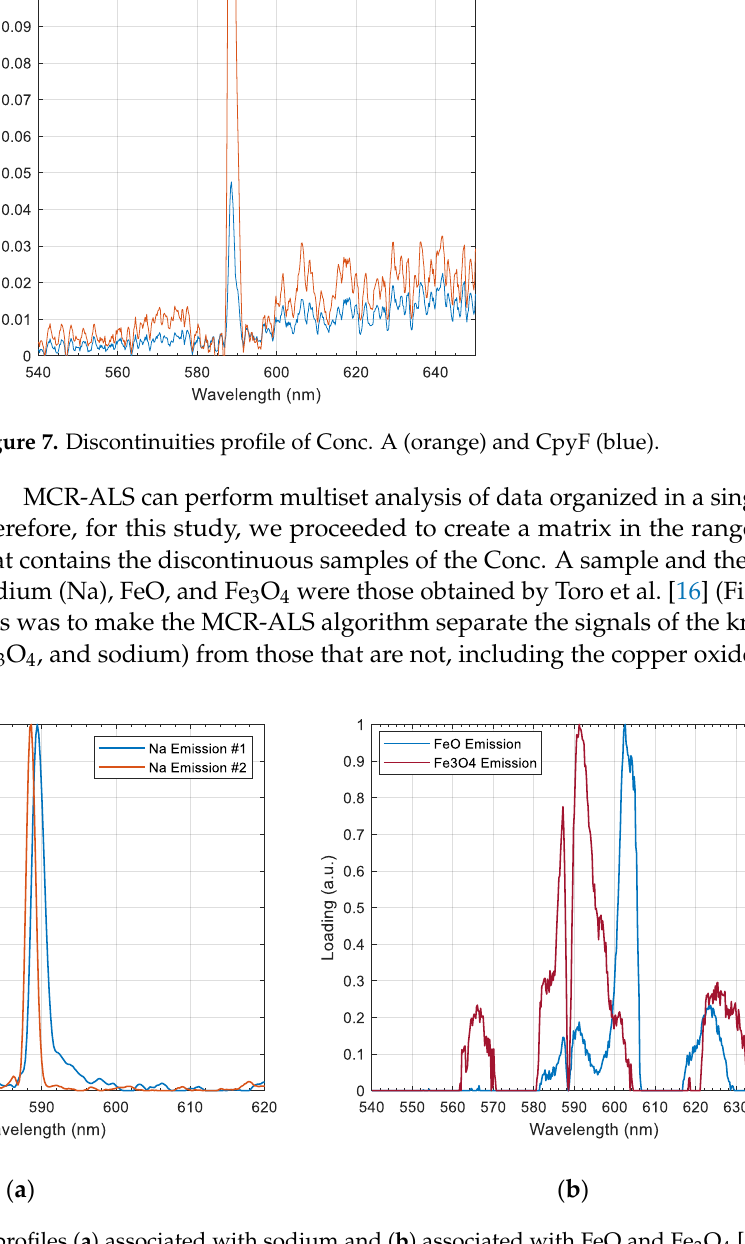
Figure 8. Spectral profiles ( a ) associated with sodium and ( b ) associated with FeO and Fe 3 O 4 [16]. The MCR-ALS method was applied to the new matrix, as detailed in Figure 9, with 10 components and a “non-negativity” restriction on spectral profiles and concentrations. With these settings on the MCR-ALS GUI, 92.5244% of the data variance and an error of fit (PCA) of 3.0201% were achieved with 70 iterations [25]. As expected, within the 10 obtained profiles were those associated with emissions of sodium (Na), FeO, and Fe 3 O 4 , in addition to a profile whose characteristics resemble the profile reported by Knapp, as seen in Figure